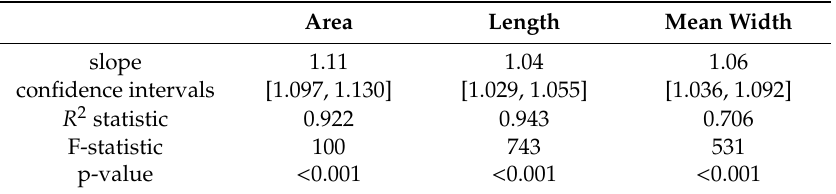
Table 8. Linear regression analysis of fracture measurement